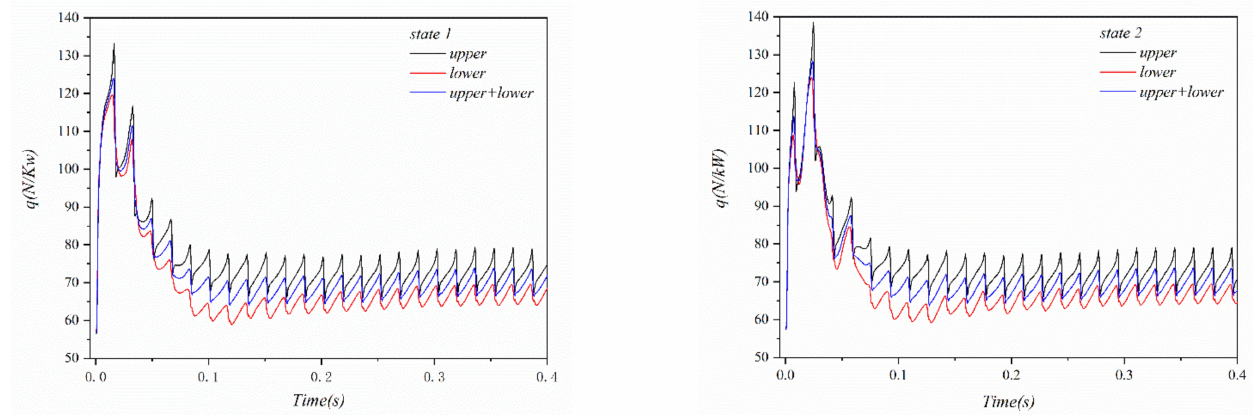
Figure 12. The isolated rotor q of the upper and lower rotors in hover.